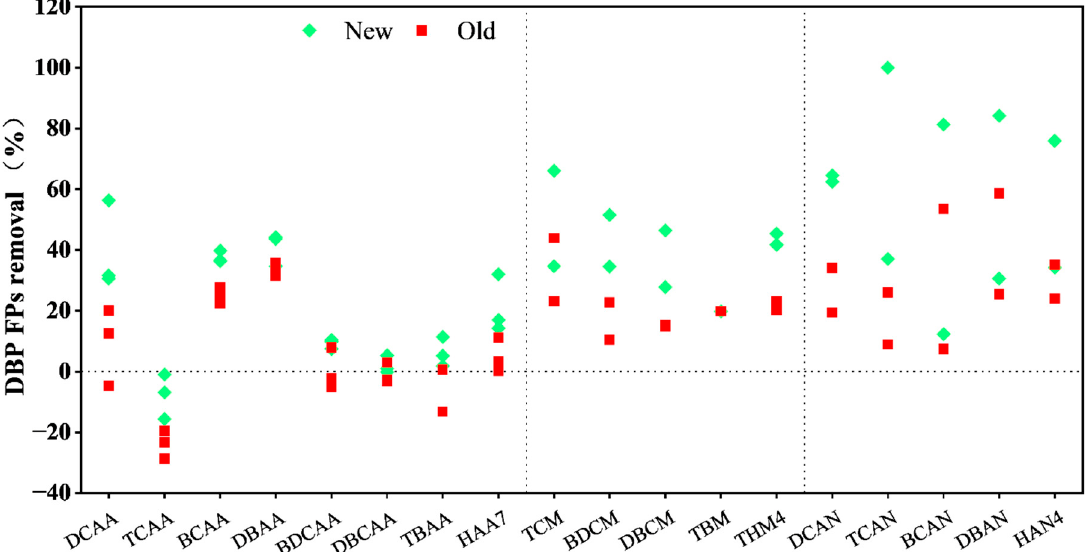
Figure 2. The removal of formation potential of THMs, HAAs, and HANs during the chloramination of old and new BAC filters. The scattered point of HAA FPs represent a single sample, and the other scattered point represents the average of three replicate samples.